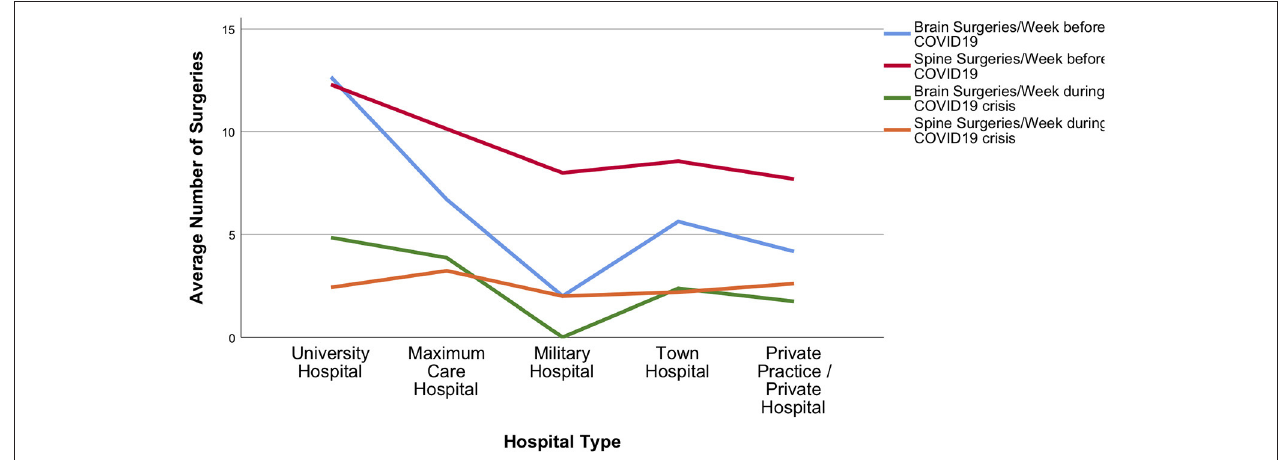
FIGURE 6 | Brain and spine surgery during the acute phase of the crisis. Detailed presentation of decline in average brain and spine surgeries among different hospital types during the COVID-19 pandemic.